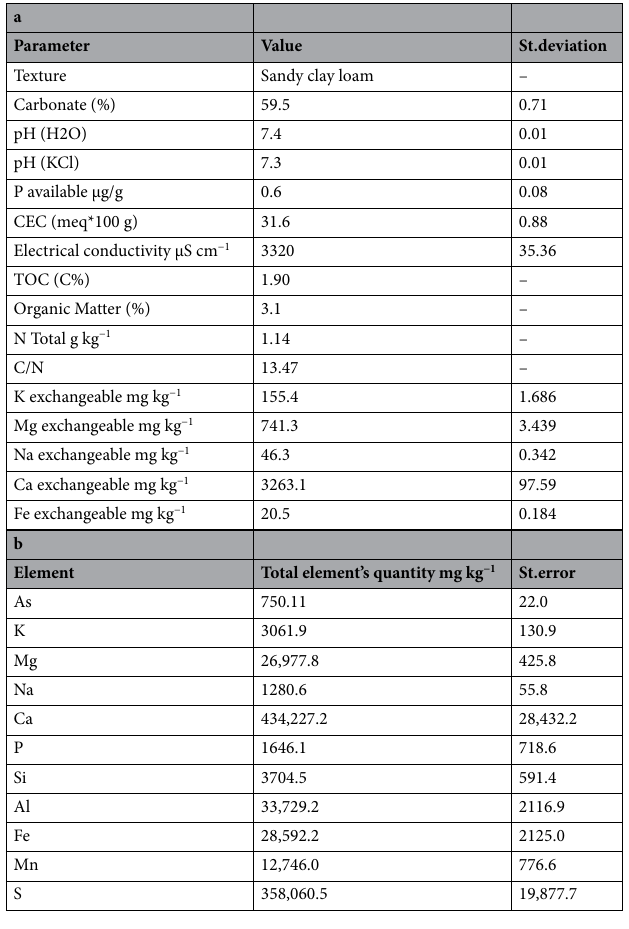
Table 1. Soil quality in Bagnaccio soil: phisical-chemical properties (a) and elemental composition (b). Standard deviations or standard errors, as indicated, are